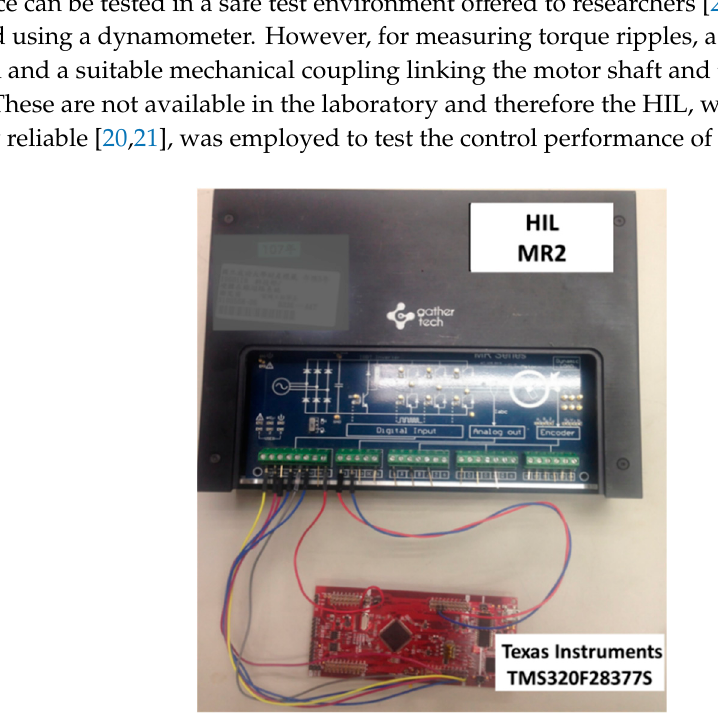
Table 2. Comparison of the simulation results for di ff erent methods.